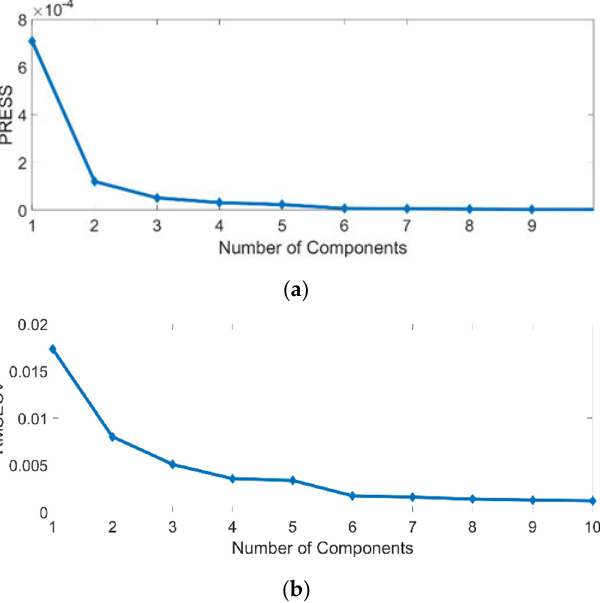
Figure 4. Plot of FAME quantification PLS model performance values of cross validation versus the number of components: ( a )—PRESS; ( b )—RMSECV.